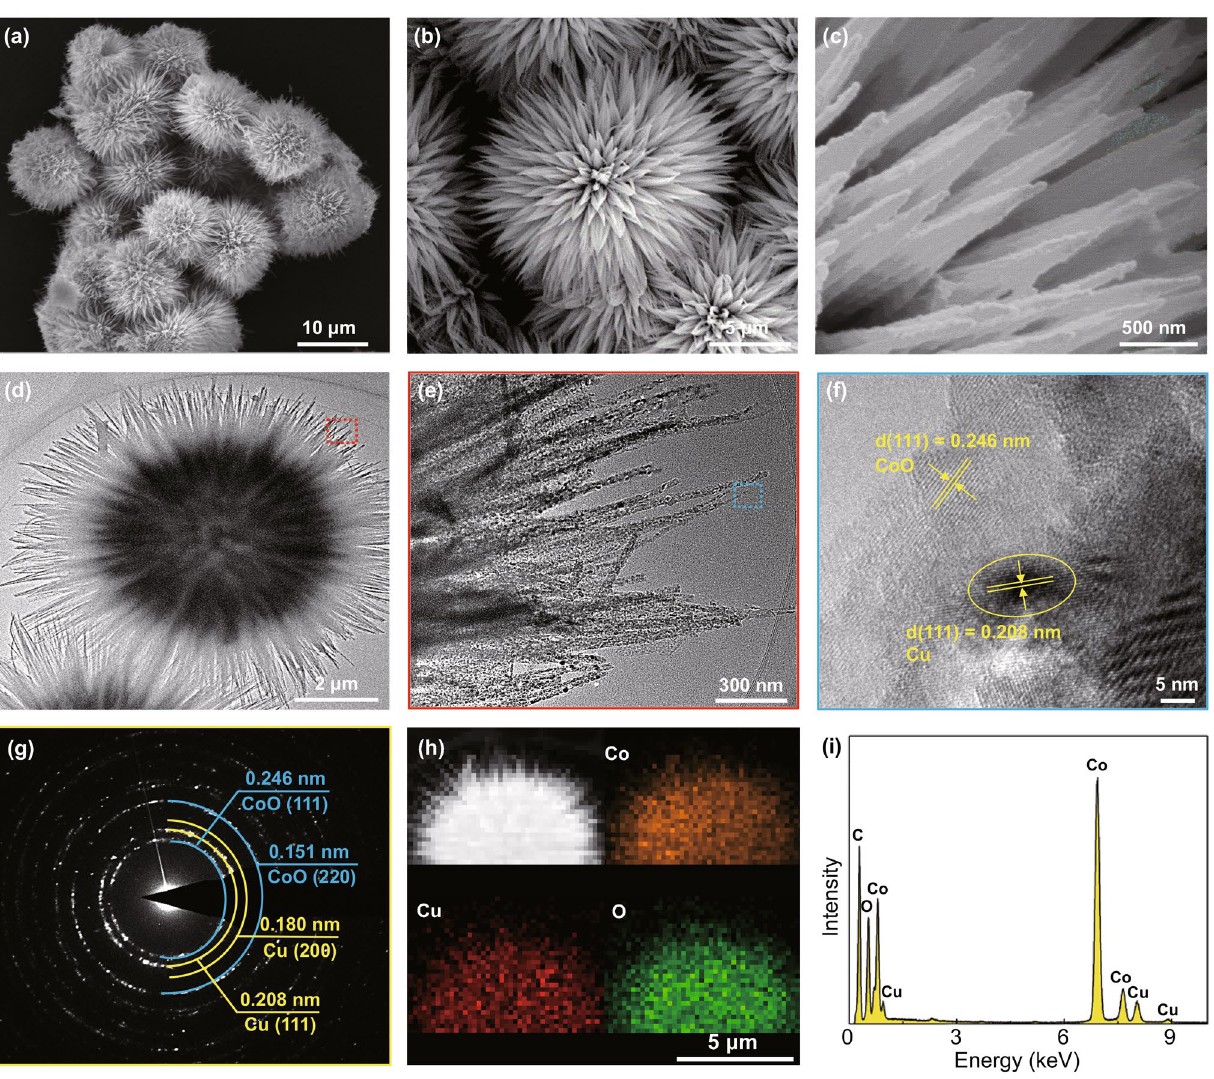
Fig. 2 CCC-0.2-450 sample: a – c Low- and high-magnification SEM images. d , e bright-field TEM images. f High-resolution TEM image. g SAED pattern. h The corresponding elemental distributions. i EDX data of the